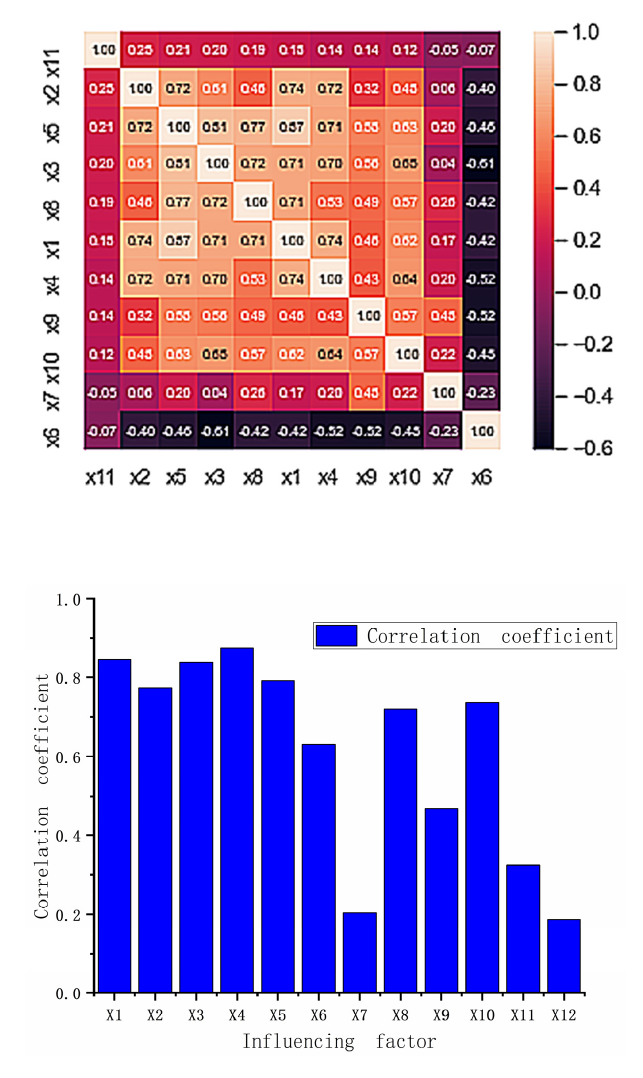
Table 2. Gas emission characteristic parameter set.